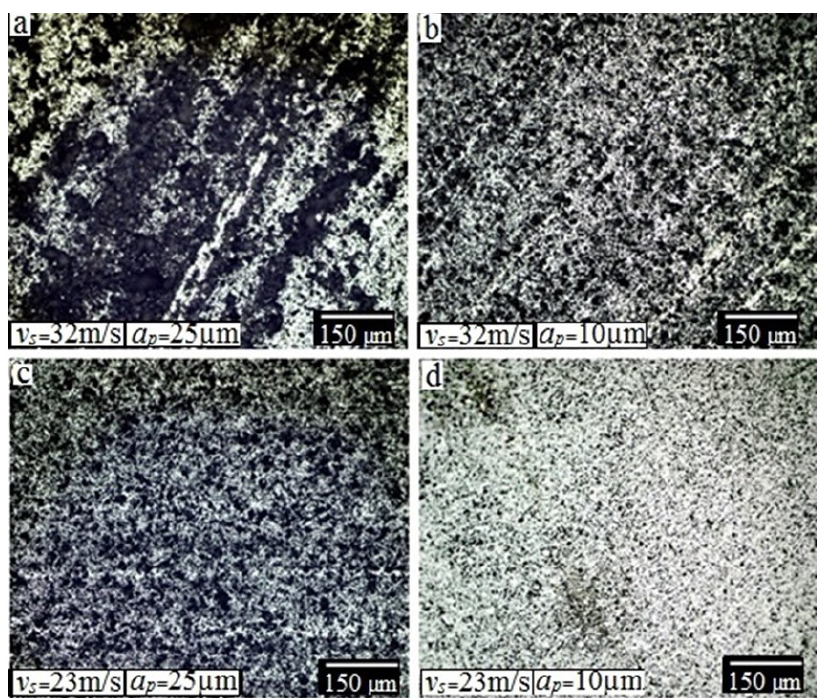
Figure 3. Light micrographs of surface characteristics for 23 m/s and 32 m/s grinding wheel speeds at 10 µm and 25 µm depth of cut. (scale bar 150 µm).